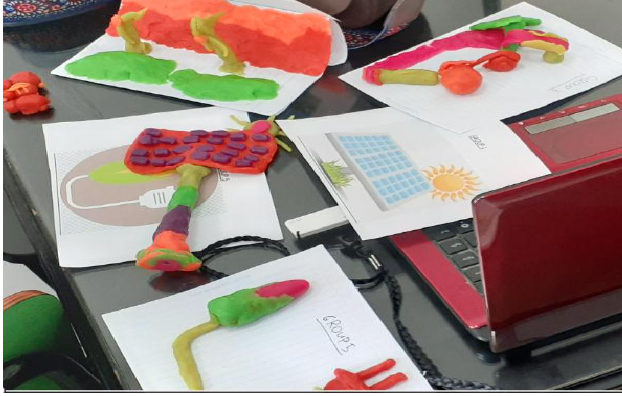
FIGURE 11 | Group Work Activity for Lesson Evaluation: Playdough Solar Panel, Windmill, and Micro Hydro Power Plant PST 4 explains,